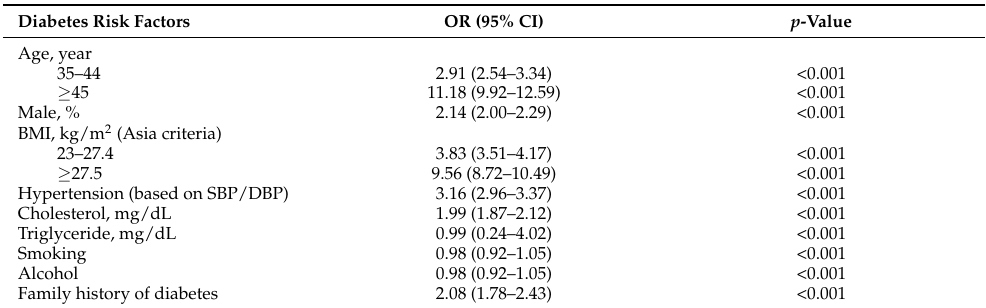
Table 2. Chinese adults’ diabetes score in the Chinese diabetes dataset (4174 diabetes cases, n = 211,833, AUC =